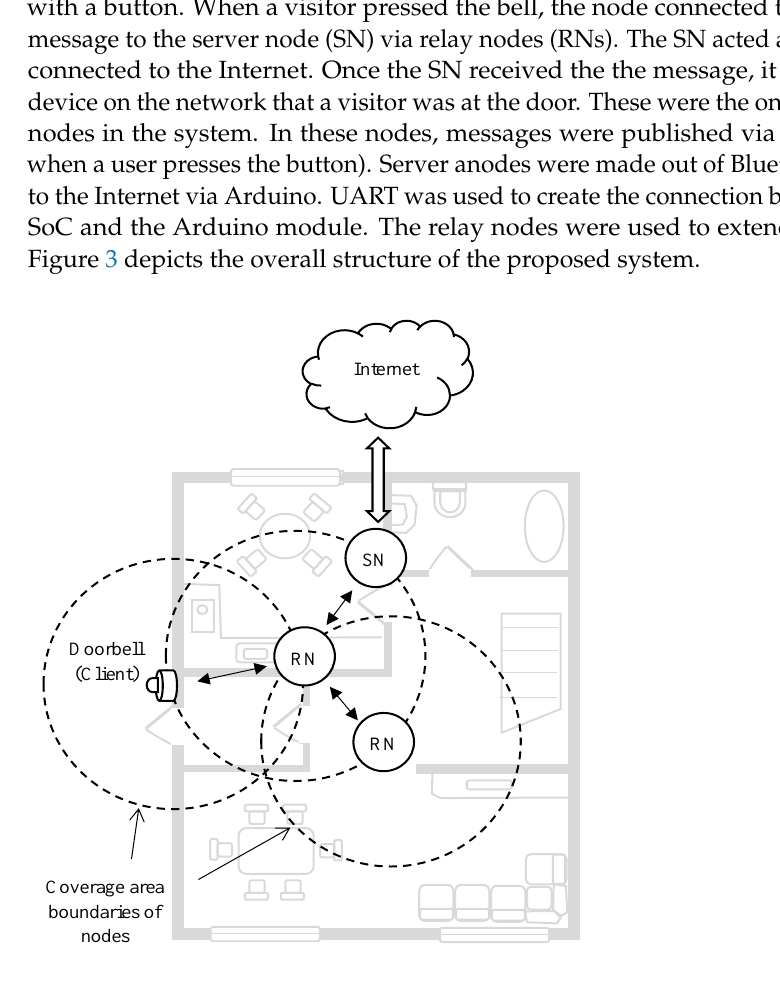
Figure 3. The BT Mesh network based smart doorbell communication structure, where “N” and “SN” denote a node and a server node,